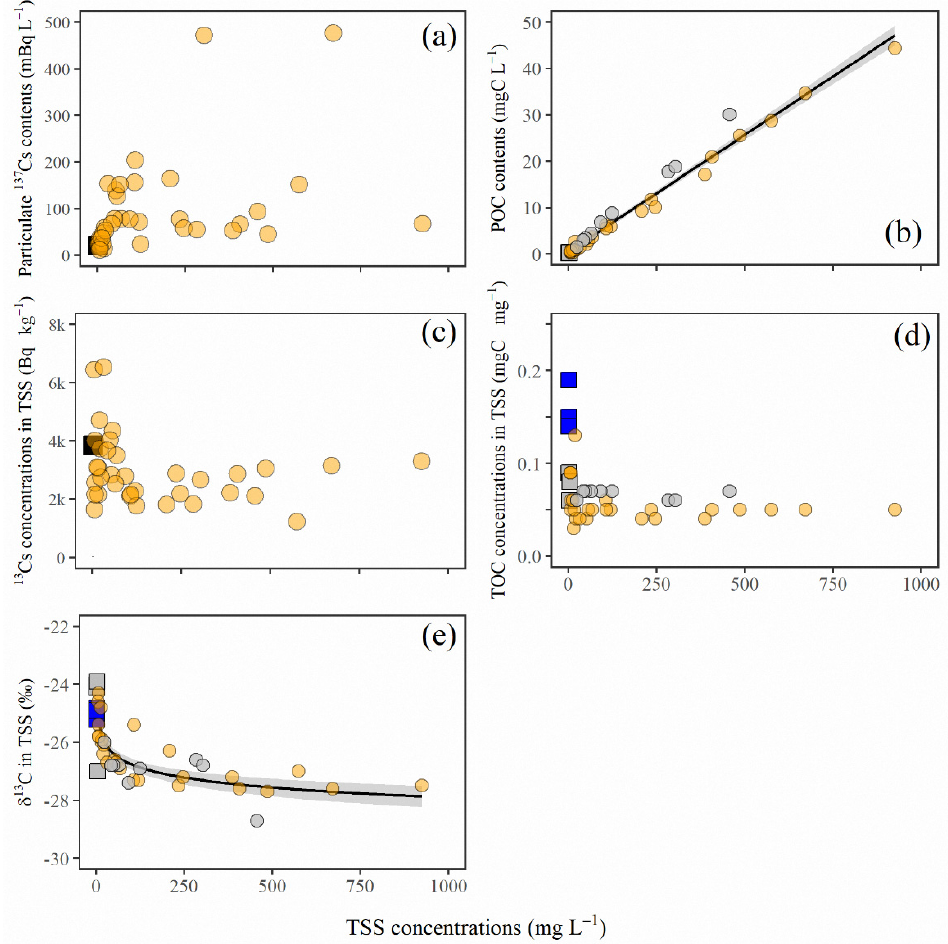
Figure 3. Changes in particulate 137 Cs, POC, 137 Cs, TOC, and δ 13 C with increasing TSS concentration. The average value and standard deviation under the base-TSS-load conditions (black squares) and all of the data measured under high-TSS-load conditions (orange circles) are shown. For POC, TOC, and δ 13 C, measured and estimated values are shown separately for each of the river conditions (gray for estimated and blue and orange for measured values, and squares for the base- and circles for the high-TSS-load conditions). ( a ) Particulate 137 Cs content; ( b ) POC content; ( c ) 137 Cs concentration; ( d ) TOC concentration; and ( e ) δ 13 C values in TSS. The shaded areas represent the 95% confidence in- tervals.